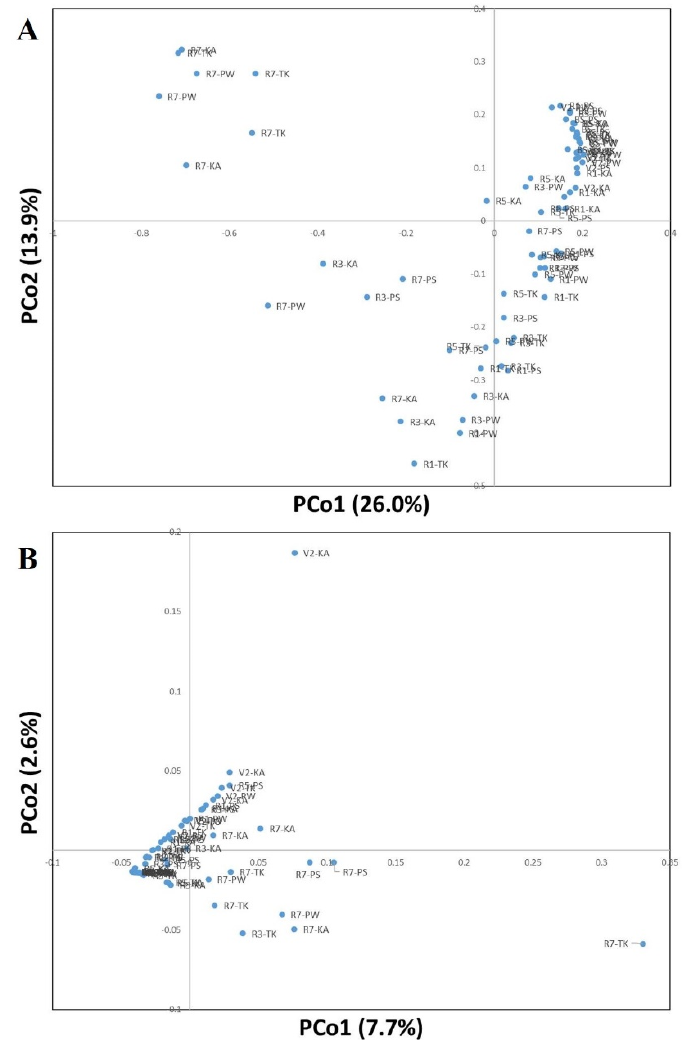
Figure 7. Principal component analysis (PCA) plotted for all the growth stages in the four soybean varieties. PCA results showing the distribution and variation of bacterial communities in the ( A ), Rhizosphere; ( B ), Root nodule.